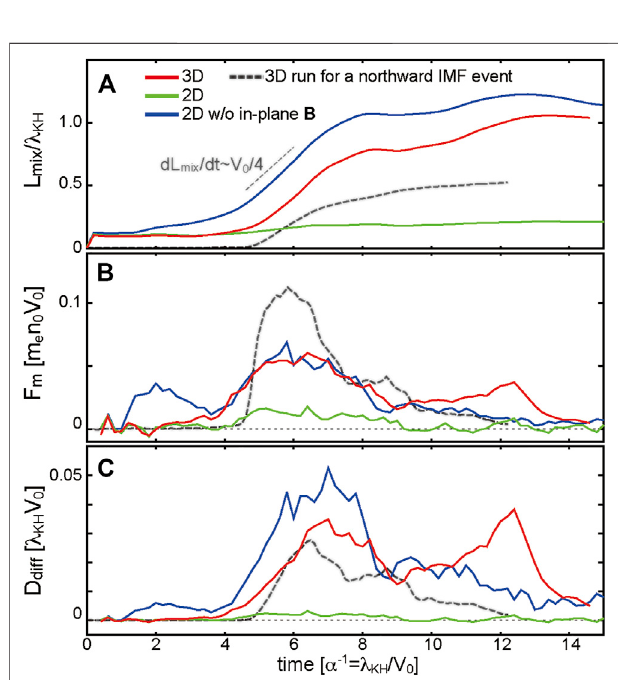
FIGURE 4 | Time evolution of (A) the y-averaged thickness L mix of the mixingregionde fi nedusing|F e | < 0.99, (B) theelectronmass fl uxF m acrossthe mixing surfaces de fi ned as |F e | (cid:1) 0.99 and (C) the diffusion coef fi cient D diff estimated from the Fick ’ s law F m / D diff (cid:1) d (m e n e )/dx ∼ m e n 0 /L mix , for the three runs and the 3-D run of the September 8 2015 event employed in Nakamura (2021) (black dashed curves), in which the KH waves were observed during northward IMF. Red, green and blue curves in Figure 4 are the same ones shown in Figure 9B in N22.